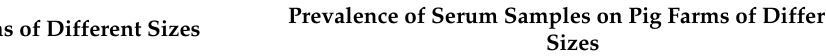
Table 2. The prevalence of pseudorabies virus in different-scale pig herds in the Henan province during